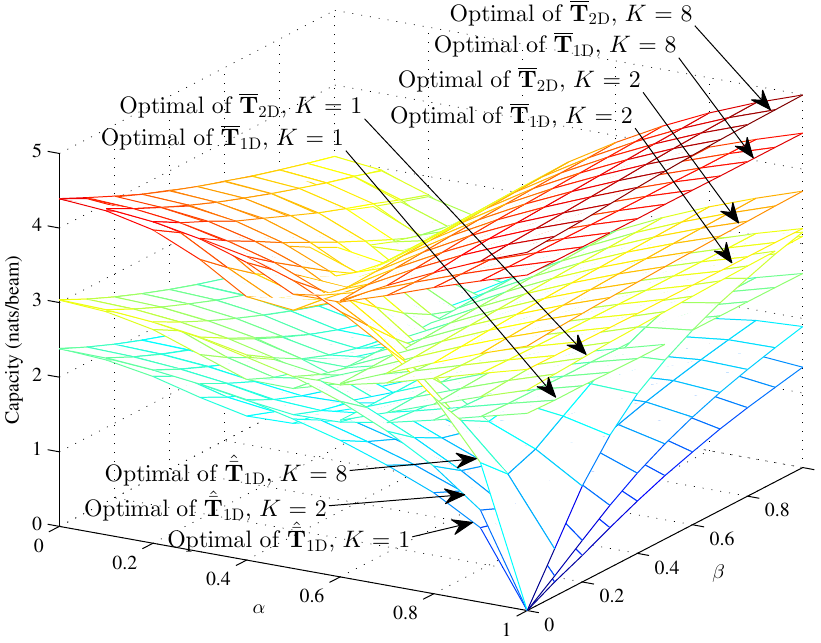
Figure 10. The optimal capacity of the hybrid 1D model and modified hybrid 1D beams with γ = 10 and N = 100, hybrid 2D model with γ = 10, L = 50 and M = 50 ( K = 1, K = 2, K = 8 and κ = 50) versus α and β